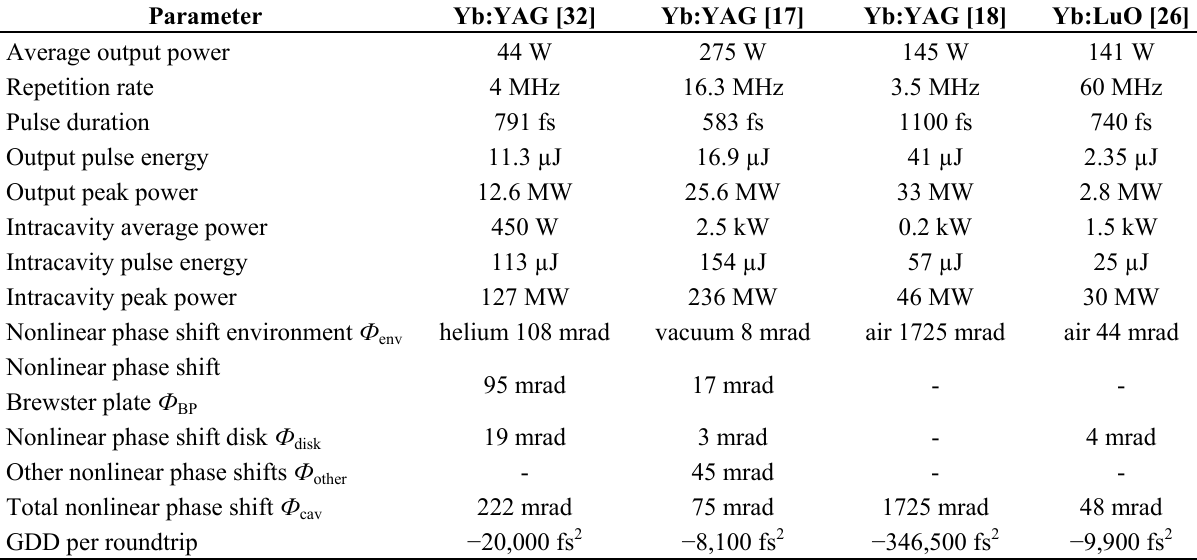
Table 1. Summary of performance and contribution of different cavity elements to nonlinear phase shift due to self-phase modulation (SPM) in state-of-the-art high-power